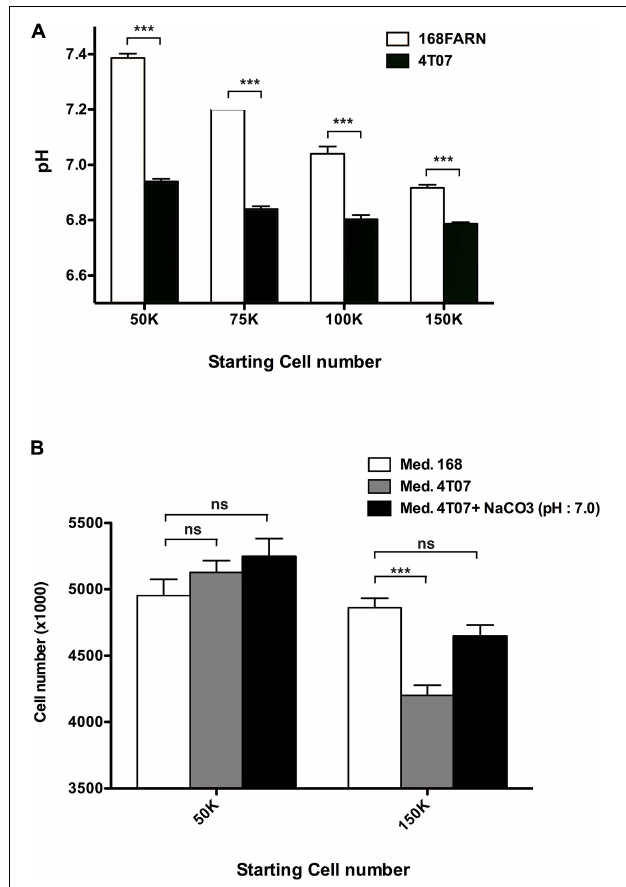
FIGURE 7 | Impact of extracellular pH on the loser clone growth. (A) 168FARN and 4T07 cells were seeded at the indicated initial densities in six-well plates and cultured for 3 days. Culture media were removed, immediately covered with a layer of mineral oil to prevent oxidation and the pH was measured. (B) 10 5 168FARN cells were grown for 3 days. Medium was then replaced by conditioned media from cultures grown at low or high density, as indicated. Where indicated, 5 mM NaCO 3 was used to buffer the 4T07 conditioned medium to pH 7. Twenty-four hours later cells were harvested and counted. Data are from three independent experiments conducted in triplicates. ns, not significant; *** p <